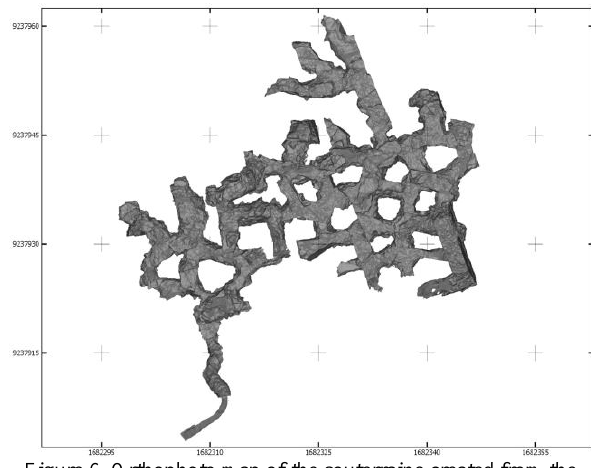
Figure 6. Orthophoto map of the souterraine created from the generated 3D model, in the French national coordinate system (RGF93